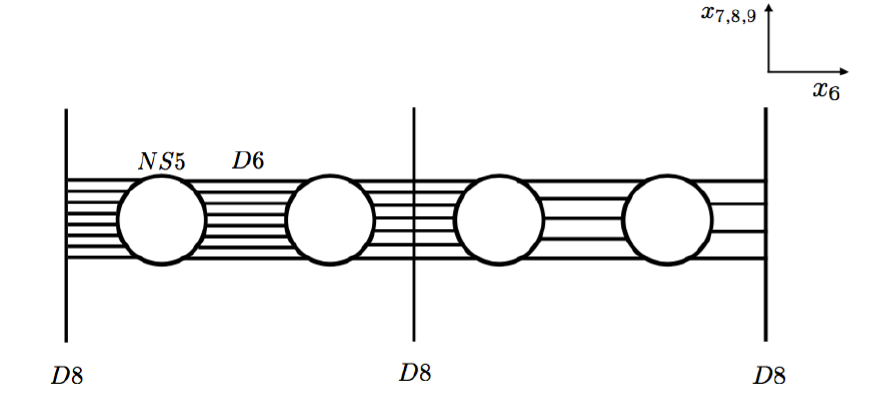
Figure 1 . The brane picture of the linear quiver realizing the above (1 ; 0) SCFT’s. In this diagram the x 6 coordinate represents z , while the directions x 7 ; 8 ; 9 are to be identi(cid:12)ed with ( r; (cid:18) 1 ; (cid:18) 2 ). D8- branes are vertical lines, D6-branes are horizontal lines, and (cid:12)nally the \fat" bubbles represent point-like NS5-branes which collide at the (cid:12)xed